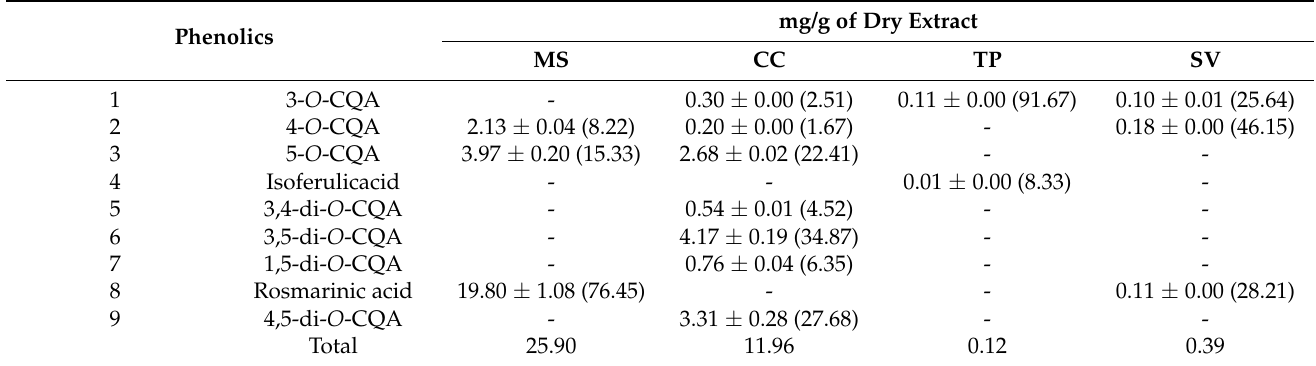
Table 2. Phenolic composition of the extracts from the M. suaveolens (MS), C. canadensis (CC), S. verbenaca (SV) and T. polium (TP).